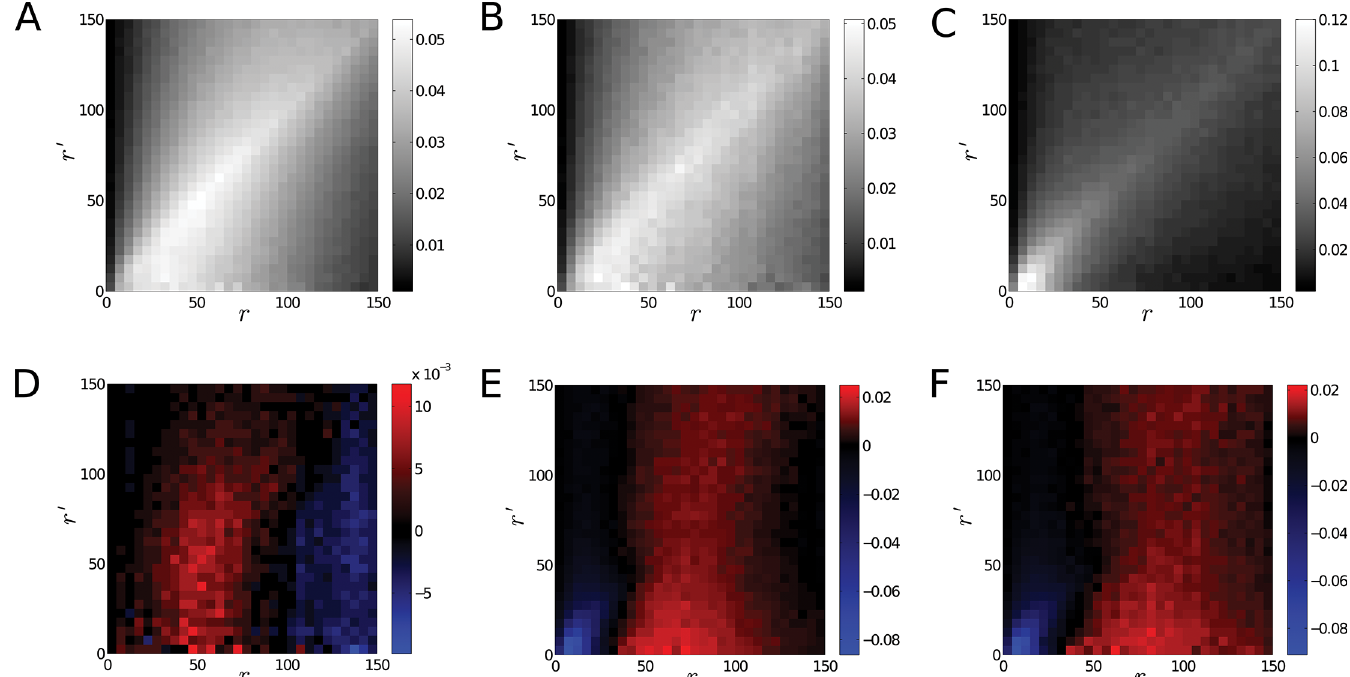
Fig 8. Conditional Probability Distribution of the Edge Lengths for Heterochromatin Markers. Panel A. The panel shows the conditional probability distribution p ( r | r 0 ) of the edge lengths calculated for the positions of the antibodies marking heterochromatic regions before irradiation. Panel B. The panel shows the conditional probability for the heterochromatin markers 30 min after irradiation. Panel C. The panel shows the conditional probability for the heterochromatin markers 48 h after irradiation. In all three cases the diagonal is emphasized indicating preferential spatial distribution of the edges. This may stem from the clustering of the heterochromatin markers. Note that although shades along the diagonal are darker in panel C, the value of the corresponding probabilities are very close to the probabilities along the diagonal of panel A except for small radii. Panel D. The panel shows the difference in the conditional probability distribution p ( r | r 0 ) before irradiation and 30 min after irradiation. A red shade of the color-map means that the probability is higher before irradiation while a blue shade means that it is higher after irradiation. The panel indicates a slightly stronger change along the diagonal indicating a more homogeneous system after irradiation. However, the change is almost independent of the value of the condition r 0 . Panel E. The panel shows the difference of the conditional probability distribution calculated for samples before and 48 h after irradiation. Shades of red indicate higher probabilities for the samples recorded before irradiation while shades of blue indicate higher probabilities in samples recorded after irradiation. Panel F. The panel illustrates the difference of the conditional probability distribution 30 min and 48 h after irradiation. Red shades correspond to higher probabilities 30 min post-irradiation while shades of blue indicate larger values 48 h after irradiation. The difference between structures observed 30 min after irradiation and 48 h after irradiation indicate a reversed trend compared to panel D.